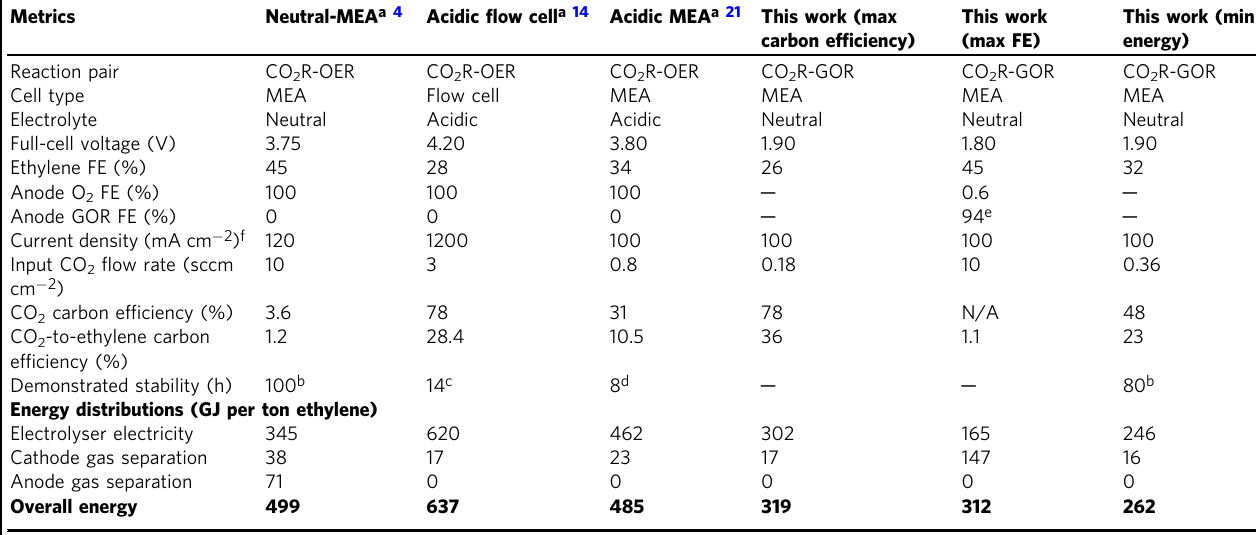
Table 1 Energy assessment comparison between the state-of-art CO 2 -to-ethylene CO 2 RR devices. Metrics